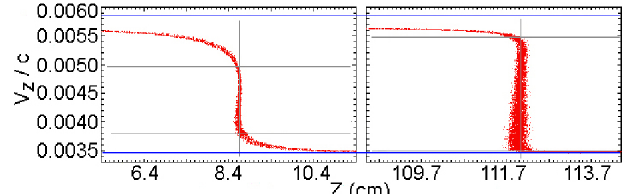
g phase space near the focal planes for the FIG. 16. (Color) f z; v z (cid:4) 100 ns (left) and t (cid:4) 500 ns (right) cases shown in Fig. 15 t p p and Table II. Blue and gray horizontal lines demarcate the and v for f (cid:4) 0 : 5 , and show the minimum v expected v h t (cid:2) t (cid:3) =I in the laboratory and maximum v achieved by the beam, respectively. b 0 t (cid:4) 200 ns (red), t (cid:4) 300 ns p p (cid:4) 500 ns p